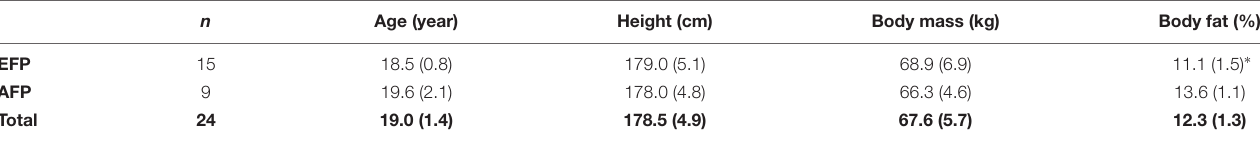
TABLE 1 | Player’s data for the agility